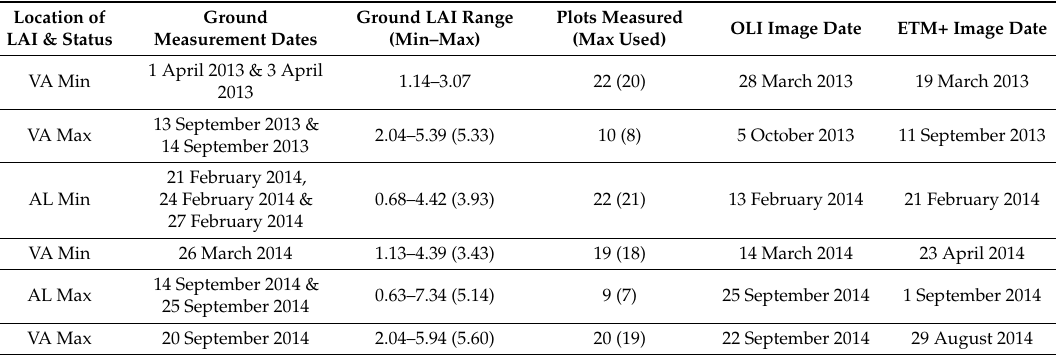
Table 1. Ground LAI measurement details by study location (Virginia: 16/34, Alabama: 21/37) and LAI status (maximum or minimum). The maximum number of plots that were used in subsequent analyses is included in parentheses in column 4. Some plots were not used due to ground data errors and atmospheric conditions (clouds and shadows). Updated values are provided in parentheses in column 3 when the LAI range changed due to plot removal.